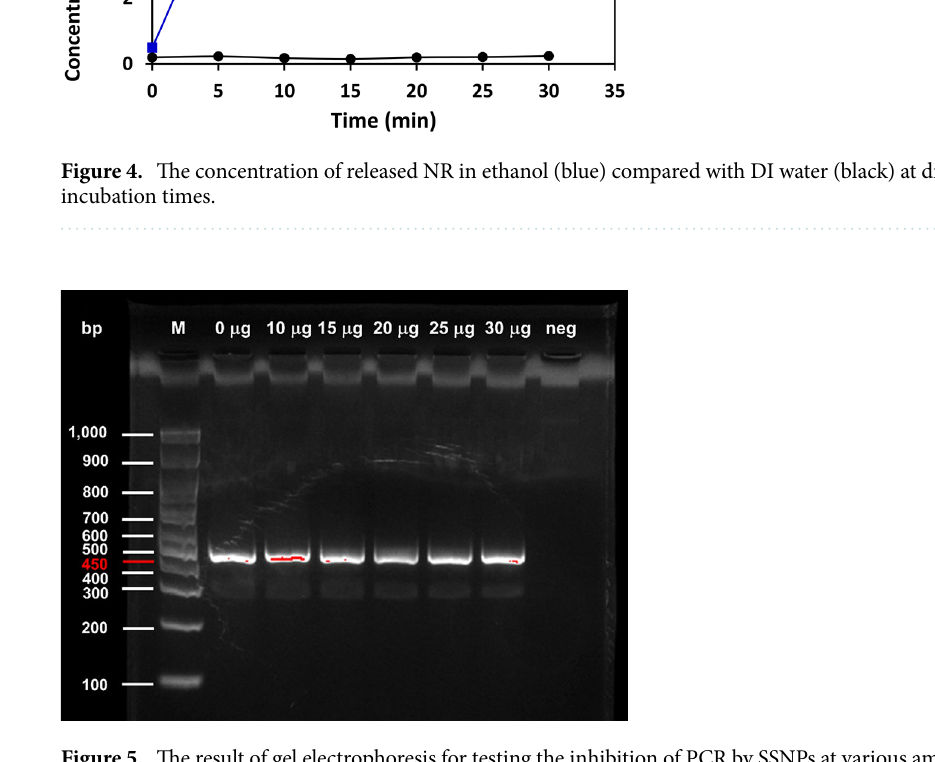
Figure 5. The result of gel electrophoresis for testing the inhibition of PCR by SSNPs at various amounts in LT gene detection (M = standard marker and neg = negative control). Original gel is presented in Supplementary Fig.